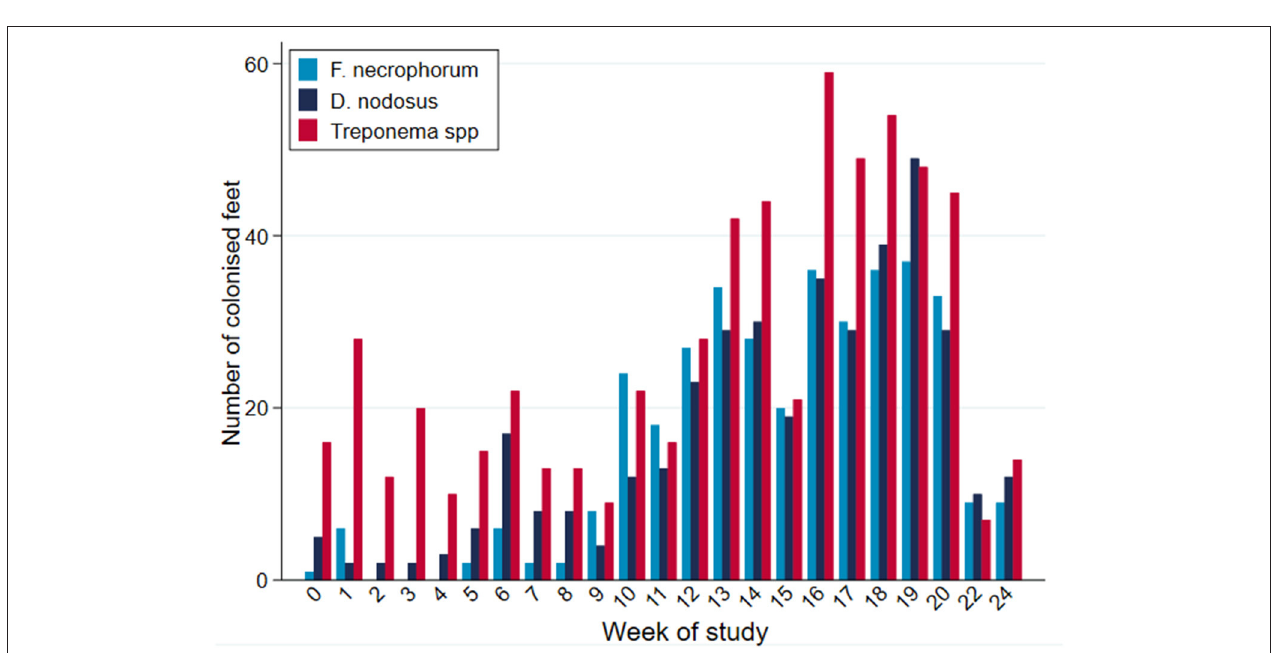
FIGURE 7 | PCR-positive results, by bacterial species, per week of study period ( n = 30 sheep, n = 120